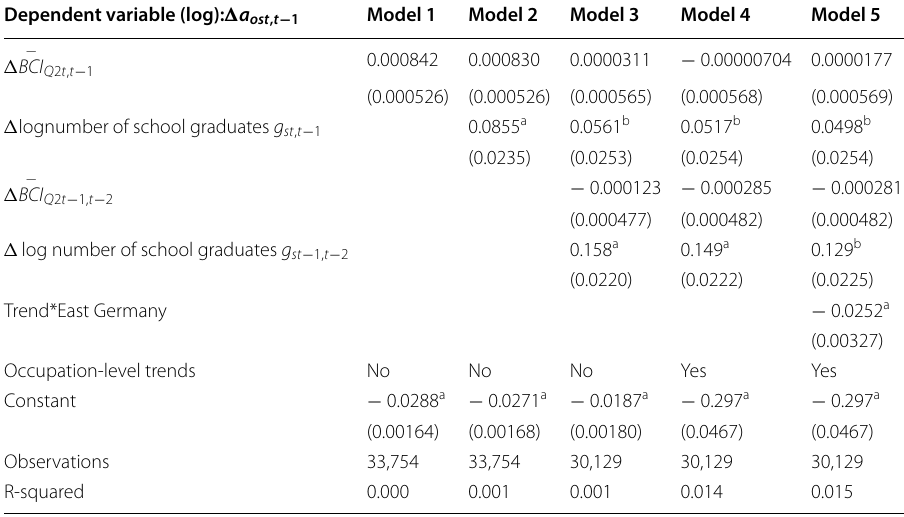
Table 10 First-differences regression (occupation-state-level, apprentices with a mid-level school